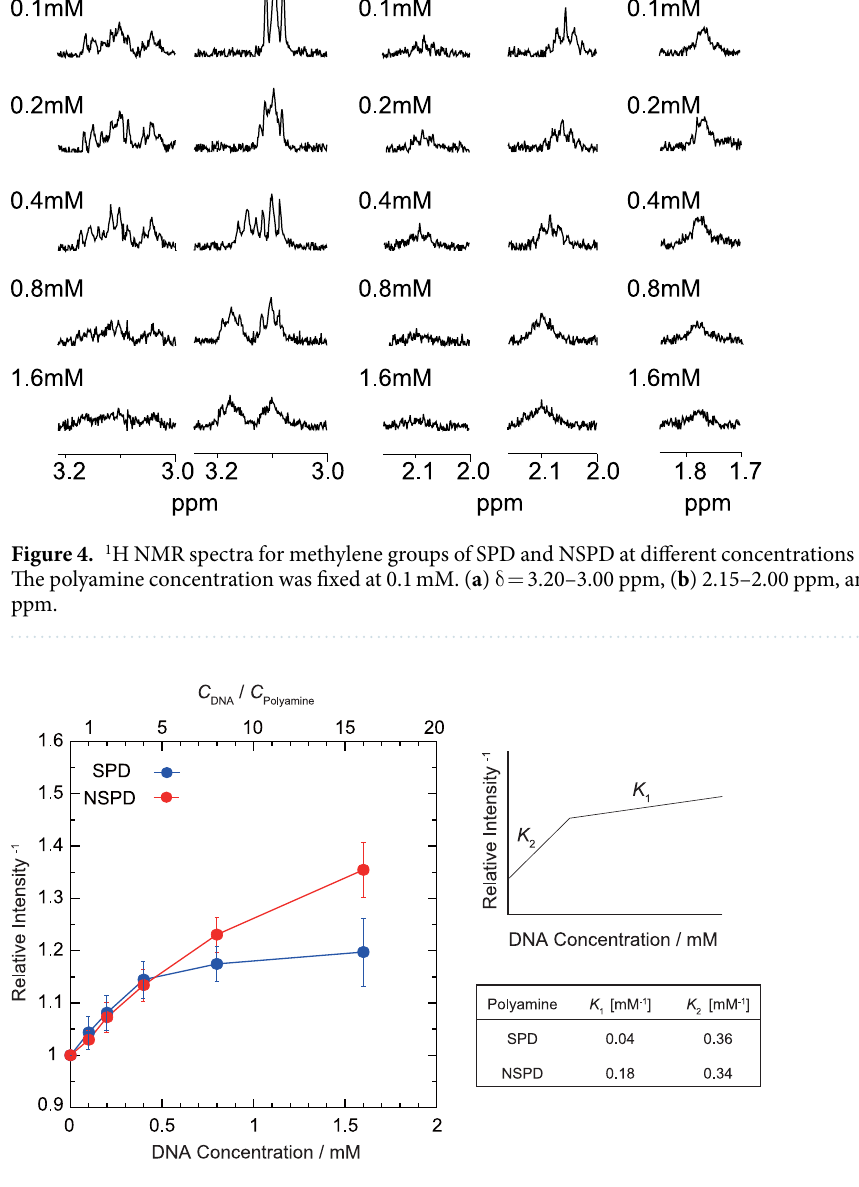
Figure 5. Left: Change in the intensity of 1 H NMR signals depending on the concentration of CT DNA. The longitudinal axis is the inverse of the 1 H NMR intensity evaluated through the integration of the observed signals, where all of the 1 H signals are well-separated as shown in Fig. 4. The signal intensities in the graph were calculated based on the sum of all of the integrated values for the spectra of SPD and NSPD, so as to minimize the experimental error. Right: Schematic illustration showing how to evaluate the binding equilibrium constant, K , from the slope of the